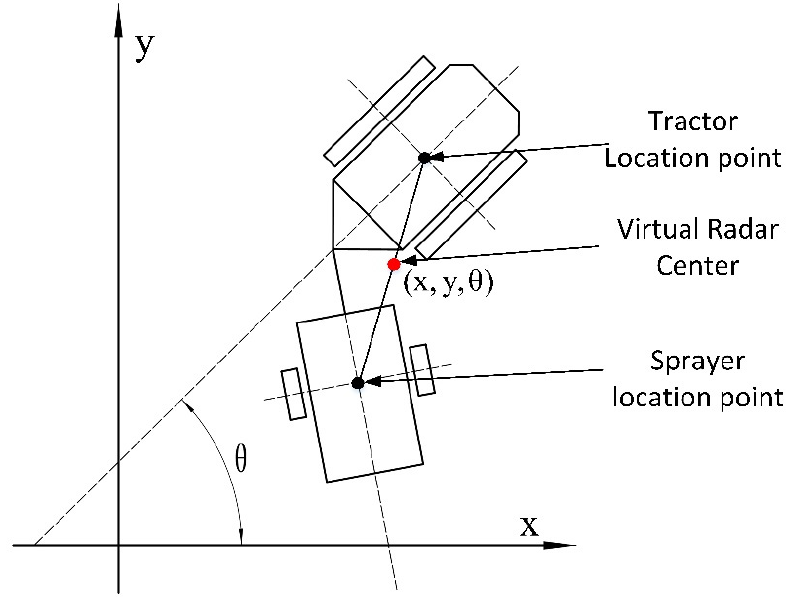
Figure 5. Schematic illustration of the main parameters of the virtual radar diagram of the orchard traction spraying robot.